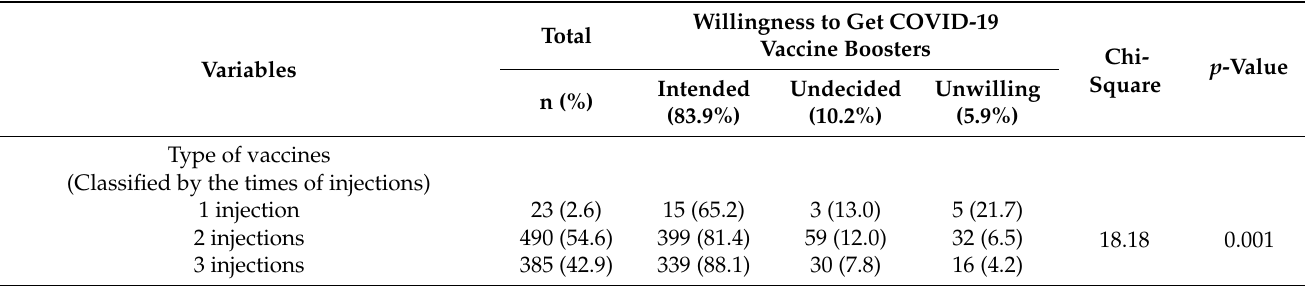
Table 2. Characteristics of participants’ COVID-19 vaccination. (n =